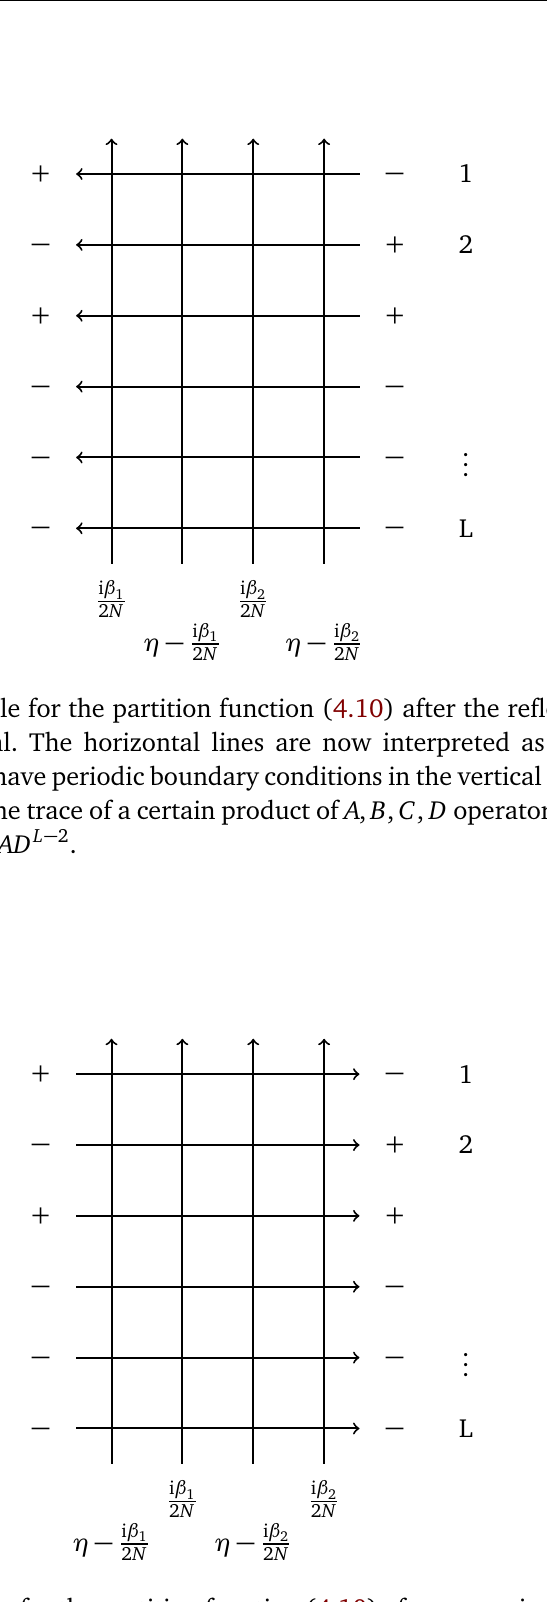
Figure 4: An example for the partition function (4.10) after a crossing transformation performed on the horizontal lines, which are now interpreted as the matrix elements of ˜ T . According to (4.16) this partition function is given by Tr CBAD L − 2 QTM